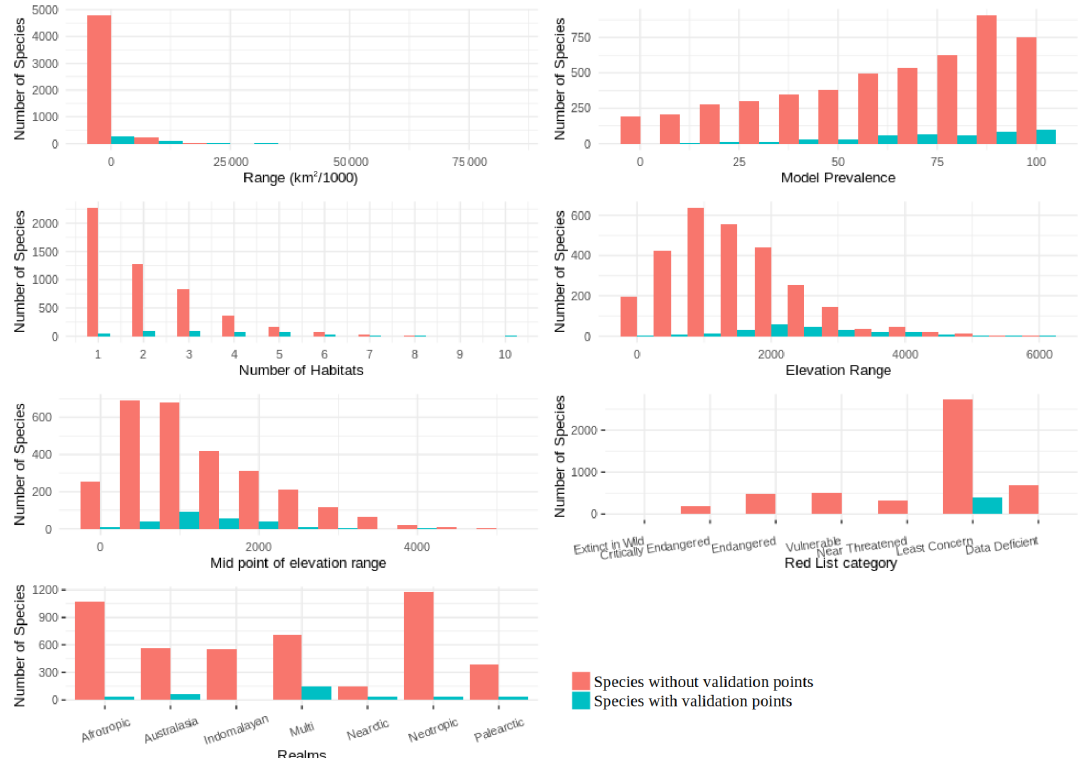
Figure A6. Comparison of species with and without validation points for mammals.